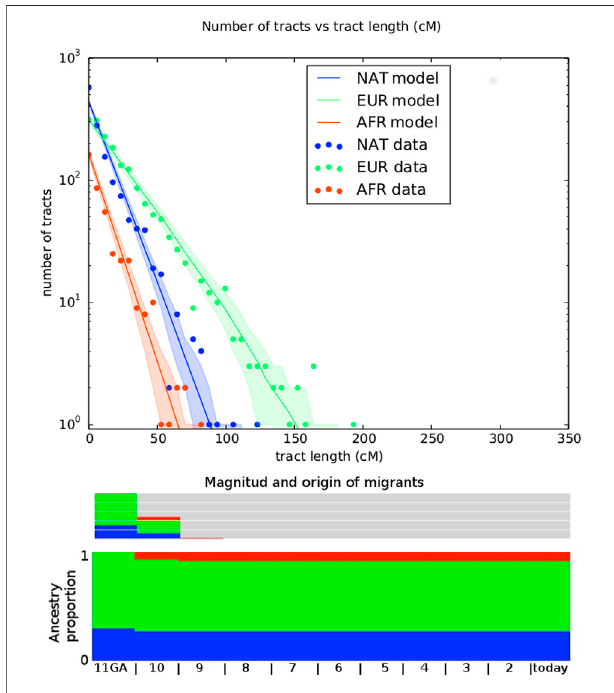
FIGURE 4 | Representation of best fi tting migration model. Top panel shows the number of tracts vs the tract length. Observed distribution of ancestry tracts is represented by scatter points, while the solid-colored lines represent the distribution of the model, with shaded areas indicating 68.3% con fi dence intervals. Models implemented in TRACTS were used to fi nd the best model that fi ts the observed data. Admixture time estimates (in number of generations ago), migration events, volume of migrants, and ancestry proportions over time are given for each population under the best- fi tting